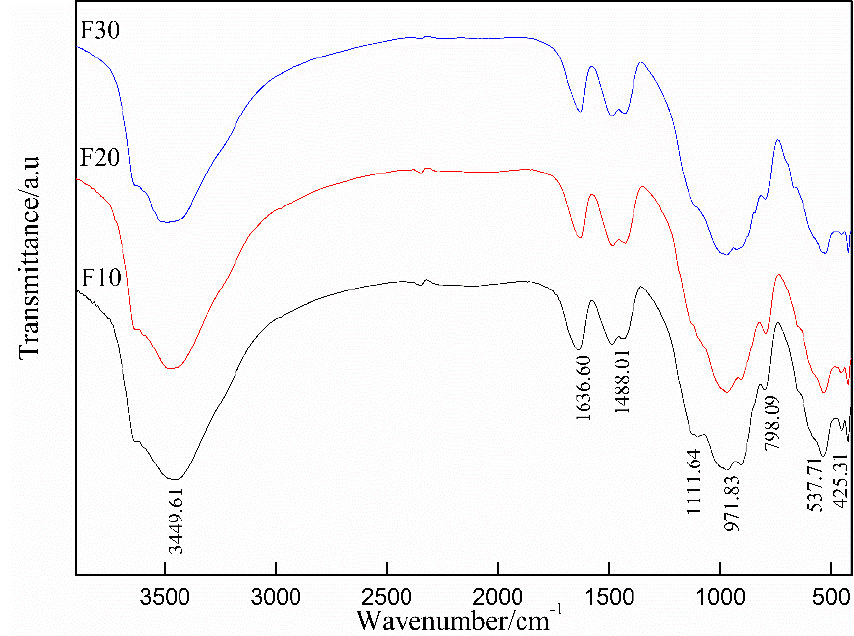
Figure 7. FTIR spectra of the samples (F10, F20, F30).